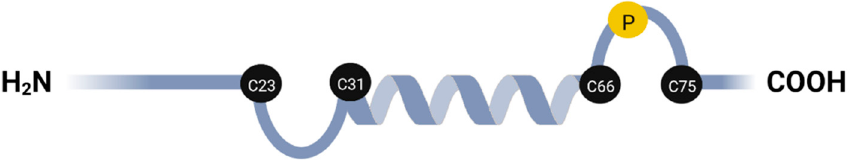
dehydrogenase (GAPDH, EC 1.2.1.13) [15].